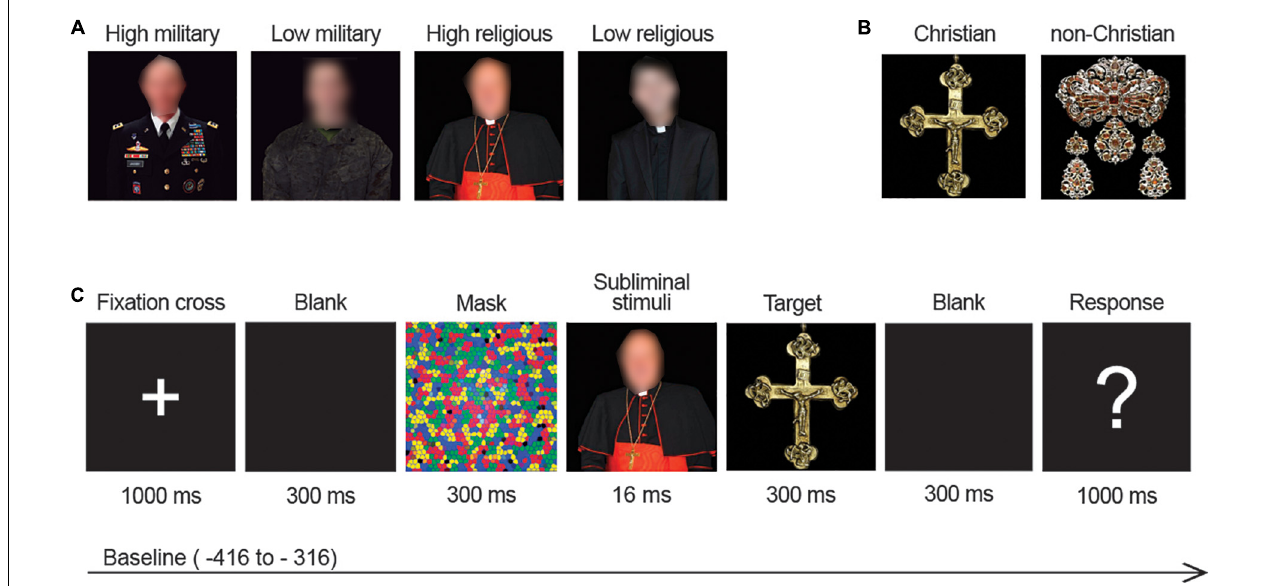
FIGURE 1 | (A) Examples of the subliminal primes (from left to right): a colonel (military type, high rank), a soldier (military type, low rank), a cardinal (religious type, high rank), and a priest (religious type, low rank). (B) Examples of target stimuli: Christian artwork (left) and non-Christian artwork (right). (C) Experimental